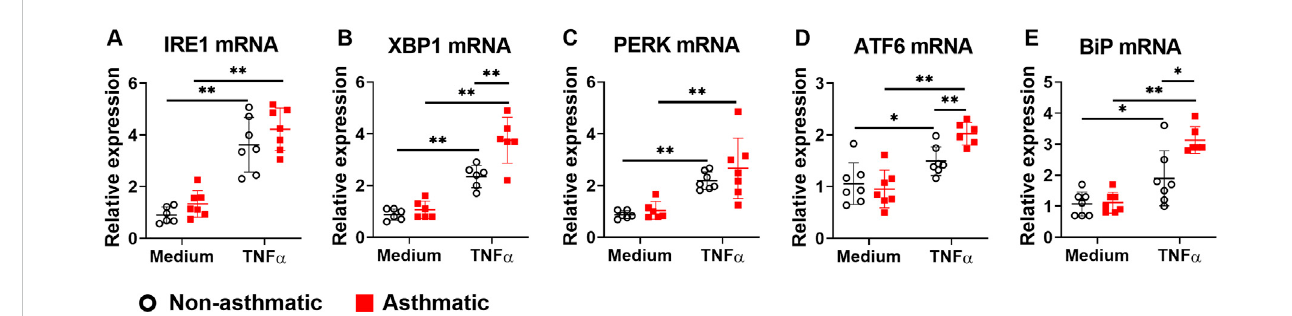
FIGURE 4 Gene expression of ER stress/UPR molecules in asthmatic and non-asthmatic human lung fi broblasts. Serum-starved fi broblasts were cultured with medium or TNF α (20 ng/ml) for 24 h. RNA was extracted from the cells. Gene expression was determined by quantitative PCR. Data are shown as mean ± SD from N = 5 – 7 patient samples. Each dot represents one patient sample. * indicates signi fi cant difference p < 0.05. ** indicates signi fi cant difference p <